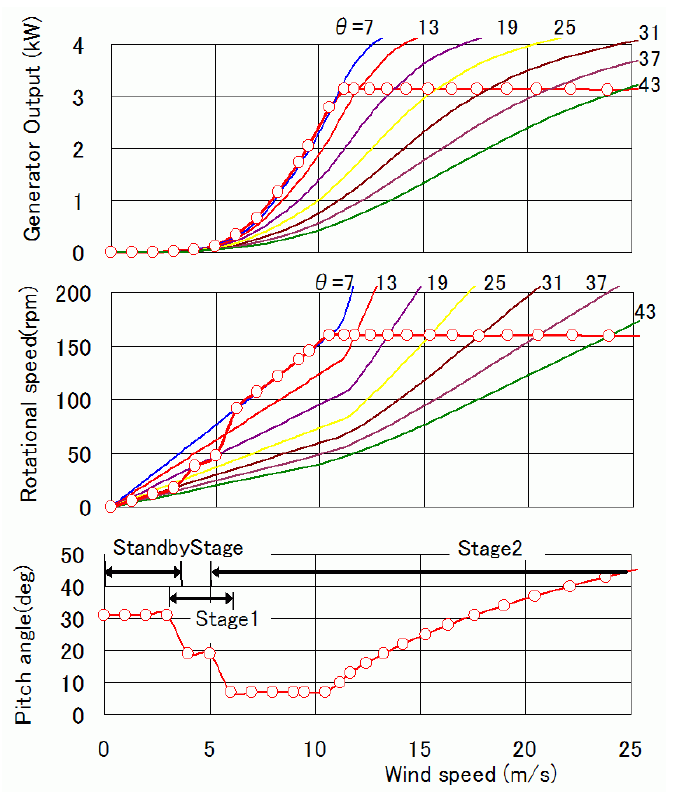
Figure 4 Performance of wind turbine